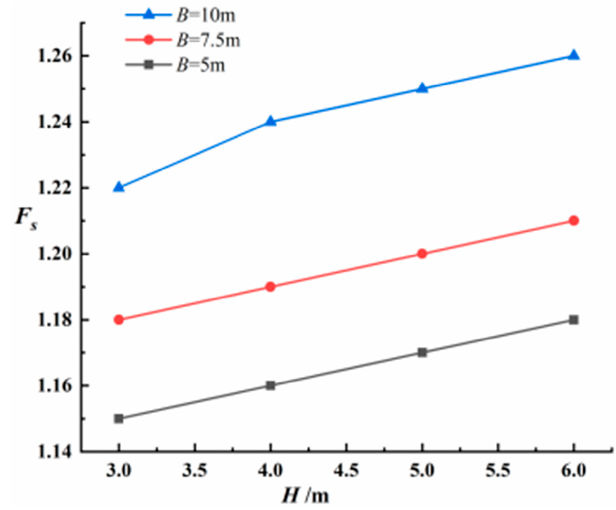
Figure 10. The stability factors of the subgrade with different ELB heights.